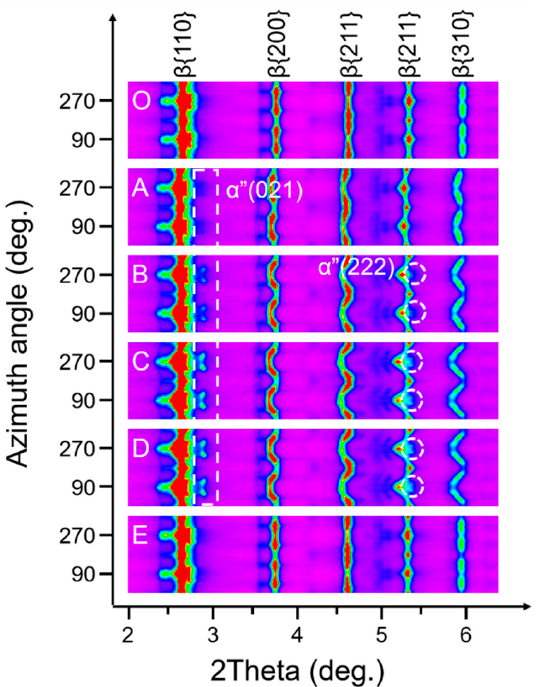
Figure 6. The unrolled 2D SXRD images along the azimuthal circle (0° to 360°) at different applied strains corresponding to points O–E in Figure 3b.